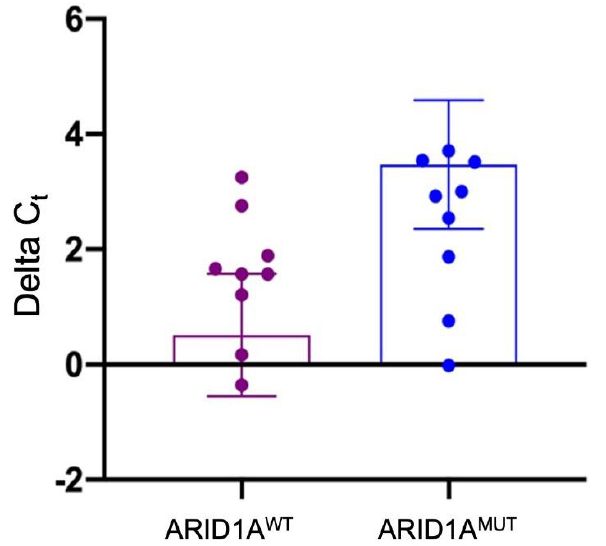
Figure 3. ARID1A expression between wildtype and mutant patients by qRT-PCR. WT : ARID1A wildtype samples; MUT : ARID1A mutant samples.